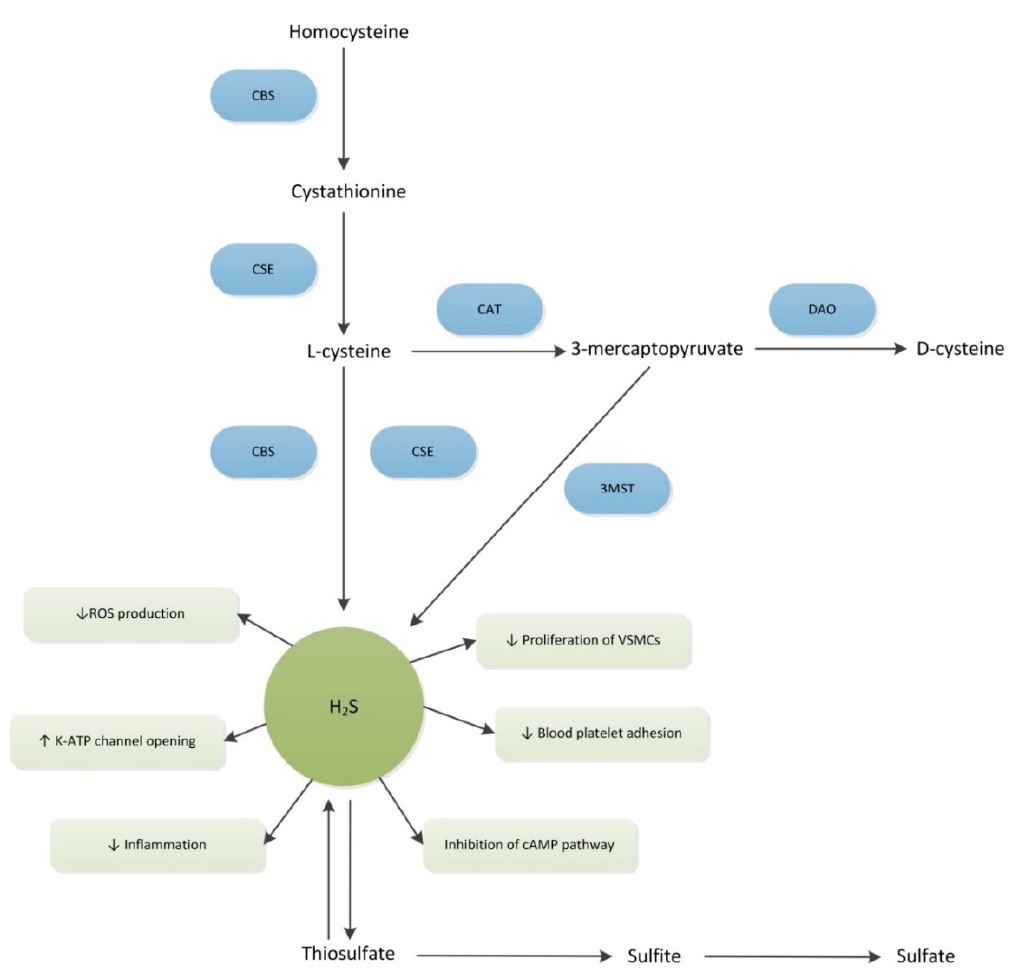
Figure 1. Schematic presentation of the production and function of hydrogen sulfide. Cystathionine β -synthase (CBS); cystathionine γ -lyase (CSE); cysteine aminotransferase (CAT); d-Amino acid oxidase (DAO); 3-mercaptopyruvate sulfurtransferase (3MST); reactive oxygen species (ROS); vascular smooth muscle cells (VSMCs); ATP-sensitive potassium channel (K-ATP); cyclic adenosine monophosphate (cAMP); Up-arrows represent up-regulations, down-arrows represent down-regulation.